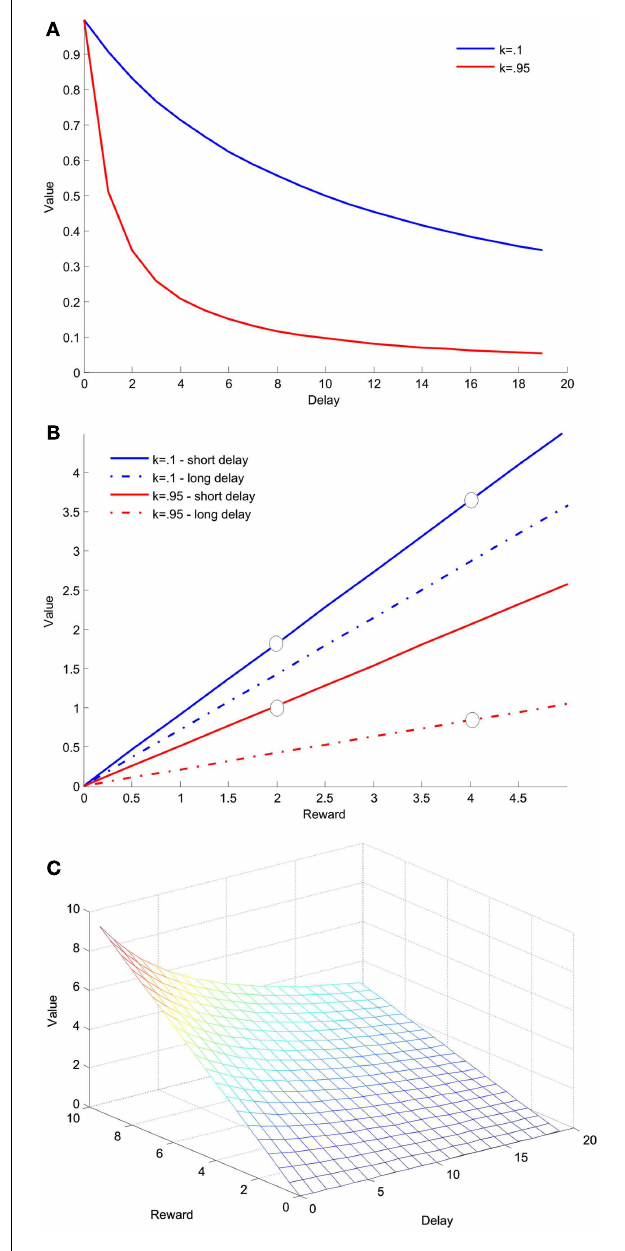
FIGURE 3 | Hyperbolic discounting of delay. This function describes theoretical data from an experiment in which two groups of animals are given a choice between two arms of a maze, one of which contains a larger-later reward, four food pellets that necessitate a wait of 15 s, and one which contained a smaller-sooner reward, two food pellets that were available after 3 s. (A) Value as a function of delay for a single reward magnitude, two food pellets, computed according to Eq. 2.3.The discount function is depicted for two values of k with higher k indicating steeper, (more impulsive) discounting. (B) Value as a function of reward magnitude for the two different and delays, 3 and 15 s, computed using the same equation.The circles show the two options presented to the two groups of animals. In this example the value of the larger-later reward is greater for the less impulsive group, and the value of the smaller-sooner reward is greater for the more impulsive group. (C) Value as a function of both delay and reward